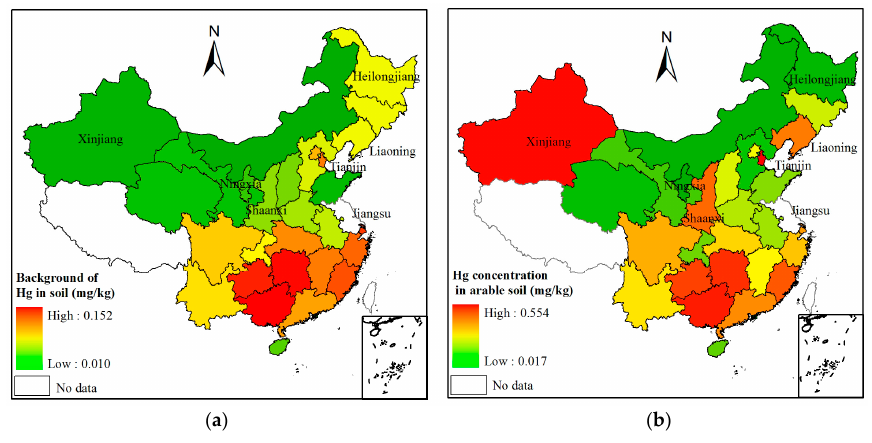
Figure 1. Spatial distribution of ( a ) background of Hg concentration in soil [28,41,42]; and ( b ) area- weighted average of Hg concentration in arable soils in the mainland of China. Note: in this section, Jiangsu Province was not involved since the background value of Hg is 0.287 mg/kg, which much different from those in other provinces. The area-weighted Hg concentration in the arable soil in Jiangsu Province is 0.1148